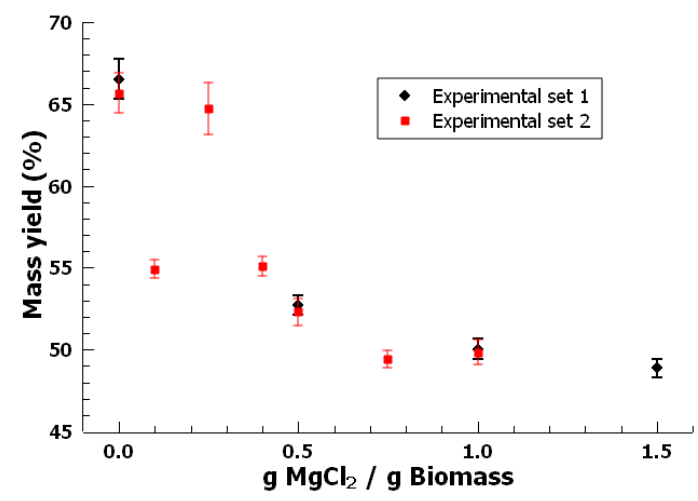
Figure 2. Effect of magnesium chloride on mass yield.